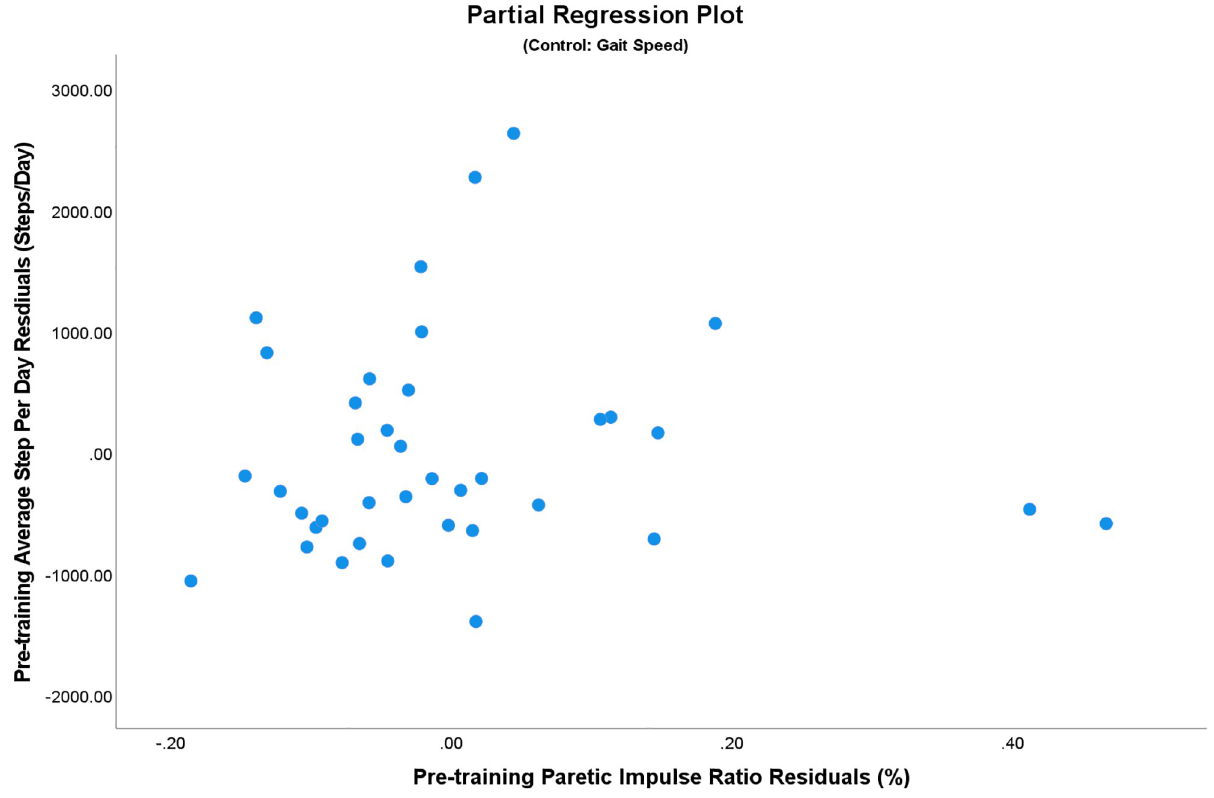
Fig 1. Partial regression residual plot of pre-training average steps per day against paretic impulse ratio, controlling for comfortable gait speed. Despite the two apparent outliers in the lower right quadrant, their removal does not change the